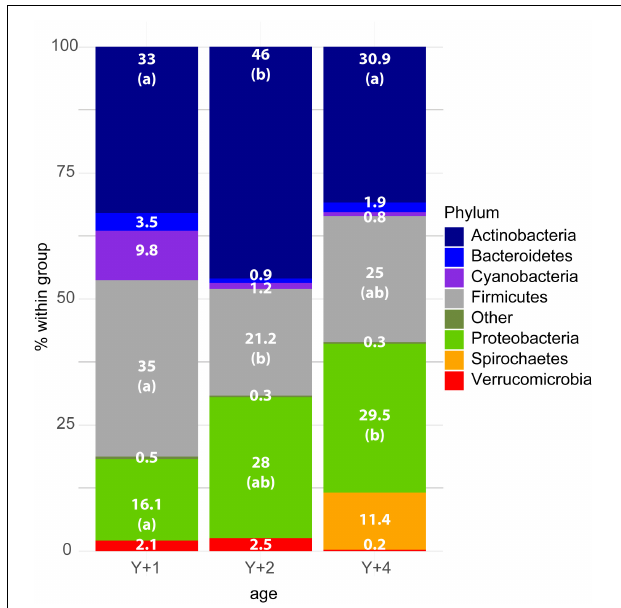
FIGURE 1 | Stacked bar chart representing the relative abundance of bacterial phyla in the different age groups. Y + 1, Y + 2, and Y + 4 correspond to 1-, 2- and 4-year-old gilthead sea bream, respectively. The Kruskal–Wallis test (post-test Dunn’s, P -value < 0.05) showed significant differences among groups for the phyla Actinobacteria, Firmicutes, and Proteobacteria. The differences are indicated by different letters in parenthesis which correspond to pairwise comparisons within each phylum among age